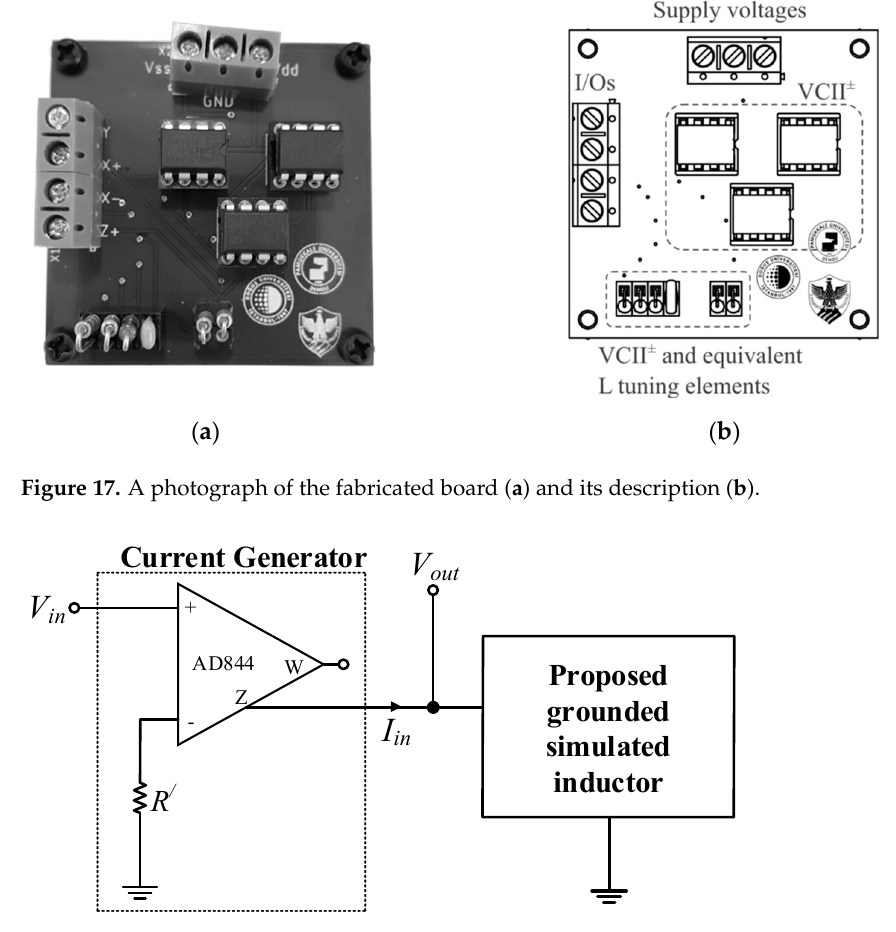
Figure 19. Measured time-domain analysis of the grounded simulated inductor.